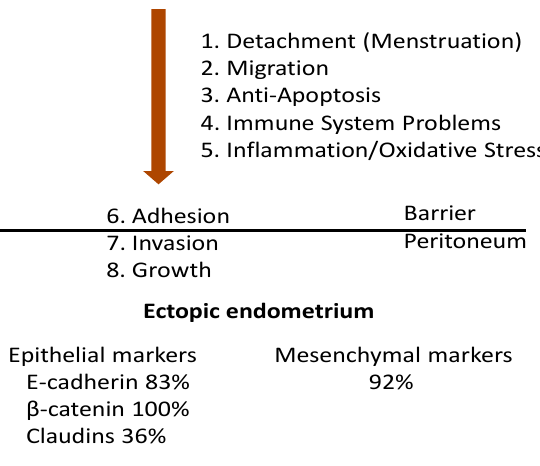
Figure 2. EMT in endometriosis. At the level of the endometrium, the epithelial EMT markers showed no differences in 87.5% of the studies, whereas the mesenchymal markers showed differences only in 18% of the studies when the eutopic endometrium of patients with and without endometriosis was compared. This suggests a partial EMT with only negligible loss of cell–cell contacts. A decreased protein expression of E-cadherin was found in 83.3% of the studies, but differences in the eutopic endometrium and the ectopic endometrium could be shown in 36.4% of the studies with claudins. The mesenchymal markers in the ectopic endometrium were different in 92% of the studies compared to the eutopic endometrium. Thus, we suggest that, after implantation, EMT was still partial with only a negligible loss of cell–cell contacts but with a strong gain in the expression of mesenchymal markers. In summary, EMT in endometriosis occurs mainly after implantation.